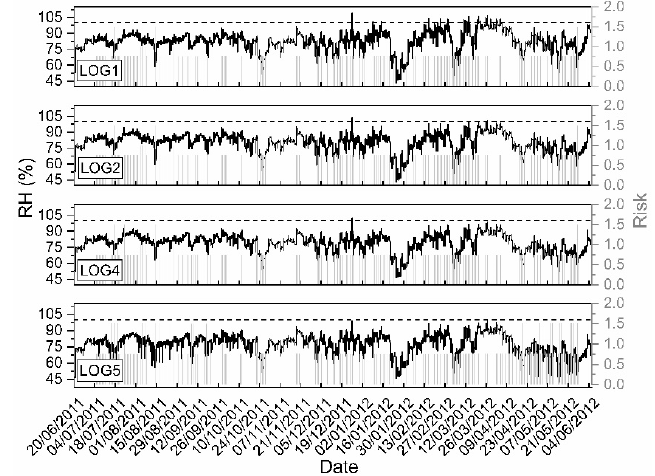
Figure 9. Indoor relative humidity (RH, %) data from the four data loggers collected between 20 / 6 / 2011 and 13 / 6 / 2012 every 2 h. Dotted lines indicate RH = 100%. Grey vertical lines indicate the level of risk (right y -axis).